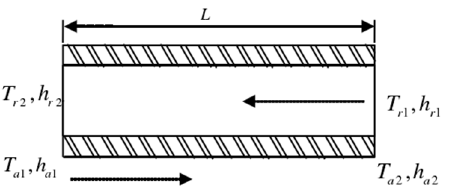
Figure 3. One-dimensional flow heat-transfer model of heat-exchanger.